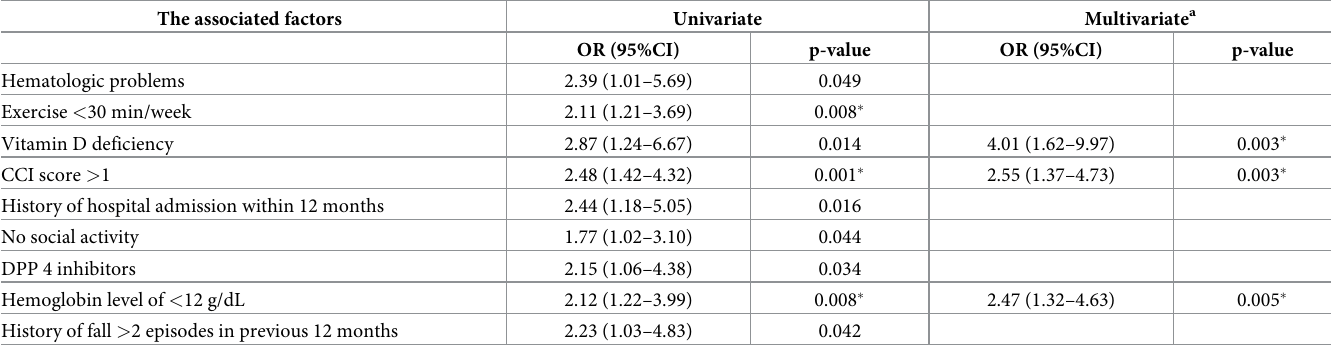
Table 6. Univariate and multivariate analysis of factors associated with